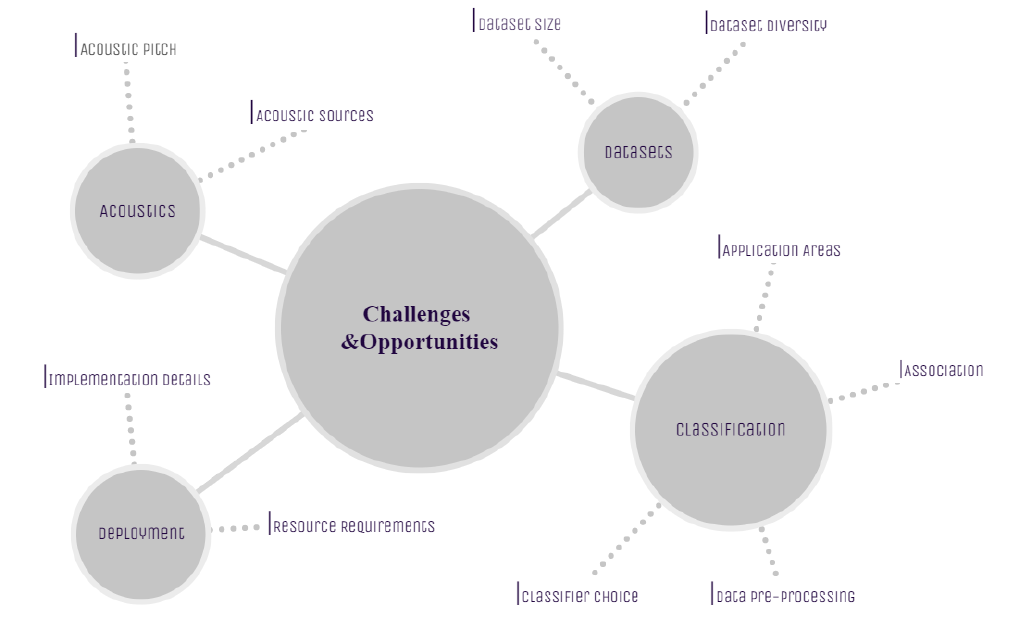
Figure 20. Summary of the challenges and